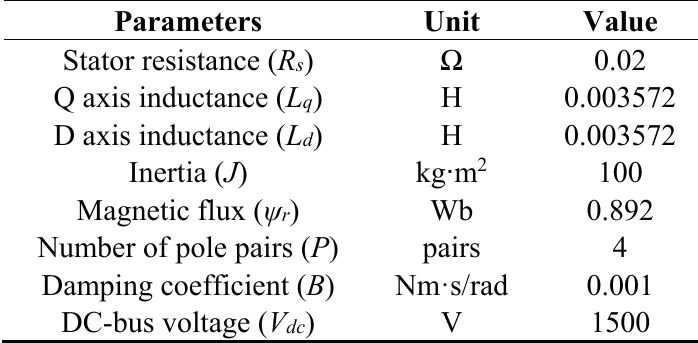
Figure 1. Block diagram of the PMSM driven system under torque closed-loop control with the extended flux linkage SMO and the FDI system. Table 2. Parameters of interior